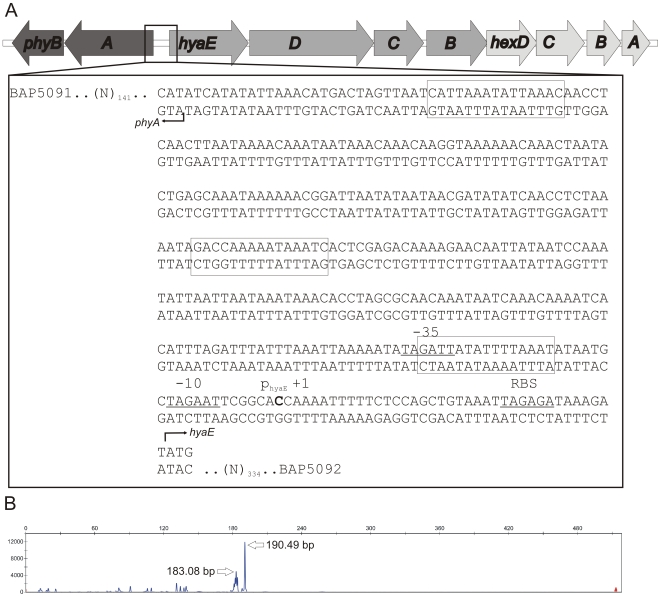
Schematic representation of the P. multocida serogroup A capsule biosynthetic locus and identification of the hyaE transcriptional start site.The organization of the genes in the capsule biosynthetic locus is shown in panel A and the nucleotide sequence of the intergenic region between phyA and hyaE is shown in the flyout box. The positions of the HyaE and PhyA translational initiation codons (ATG) are designated by right-angled arrowheads and the identified transcriptional start site for hyaE is shown in bold text and labeled +1. Predicted RBS, −10 and −35 sites are underlined, and labeled above the sequence. Predicted Fis binding sites based on the E. coli position specific weight matrix are boxed [15]. The length (x-axis) and quantity (y-axis) of hyaE-specific primer extension products generated using VP161 total RNA and the primer BAP5476 are shown in panel B. The exact size (in bp) of the major primer extension products are shown beside the peaks.